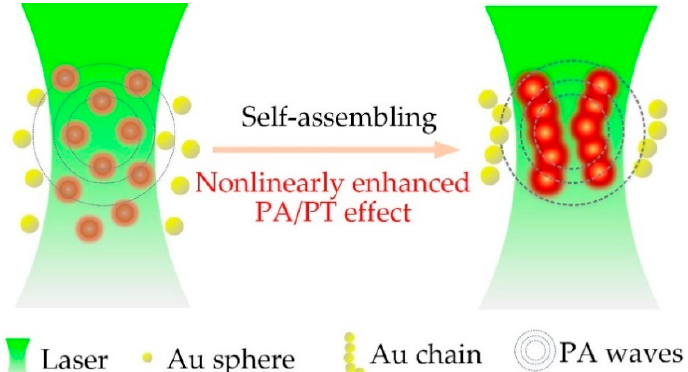
Figure 1. The schematic diagram of the nonlinearly enhanced photoacoustic/photothermal (PA/PT) effect for nanoassemblies.